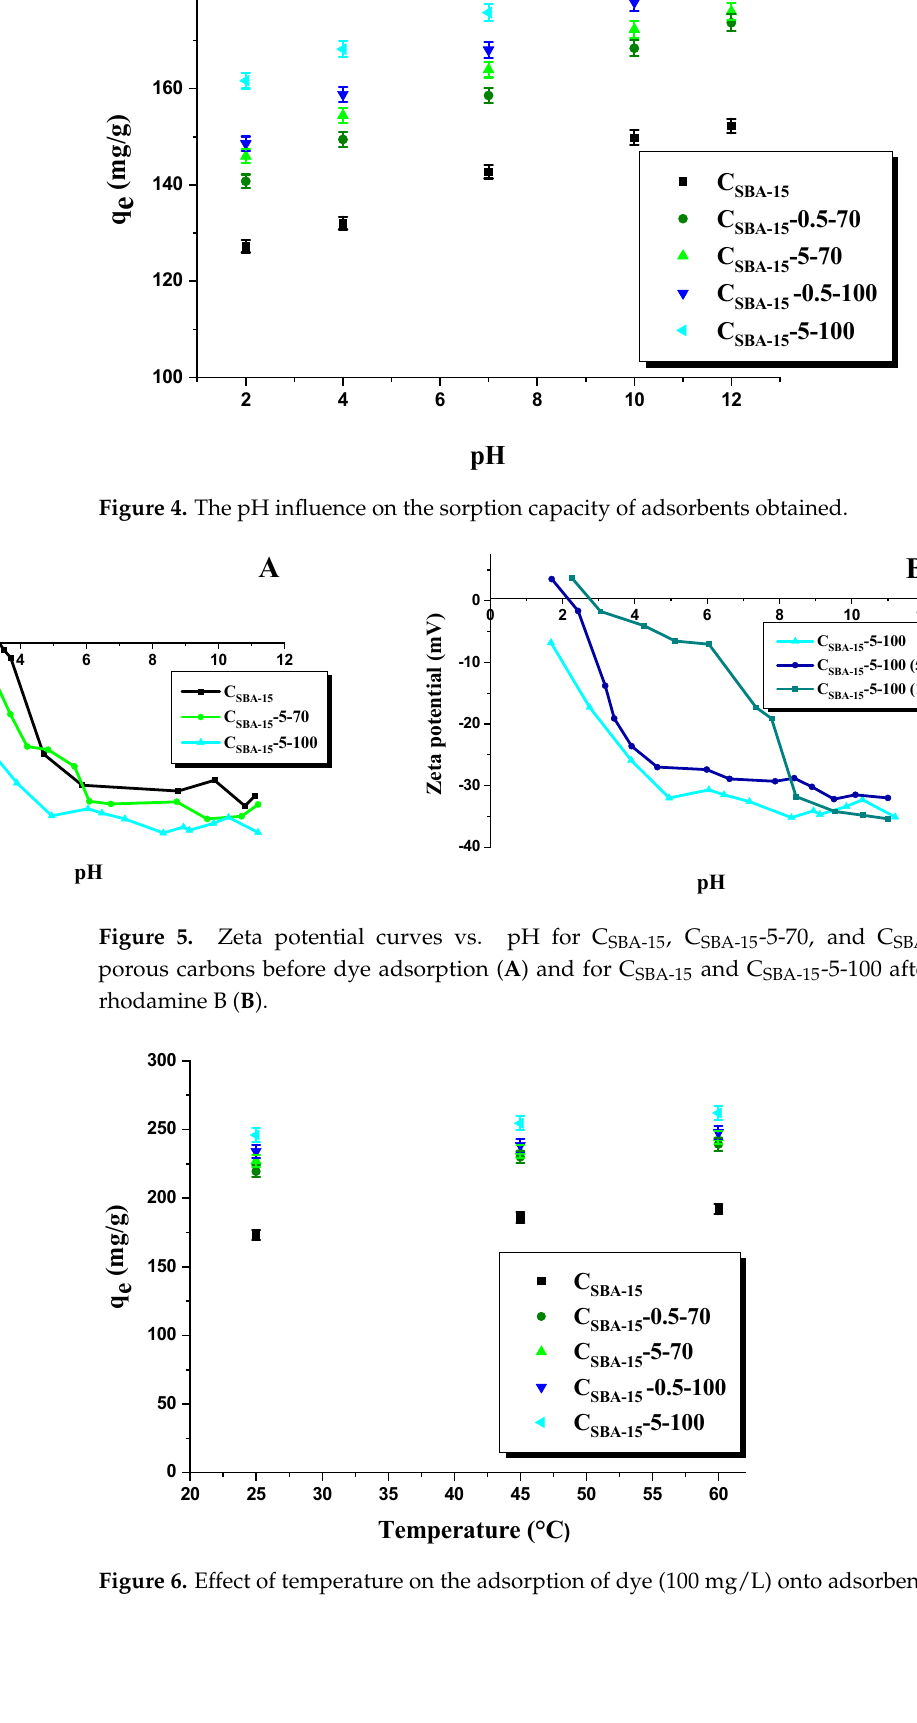
Table 4. Thermodynamic parameters obtained. Adsorbent Temperature (°C) ∆ G 0 (kJ × mol − 1 )